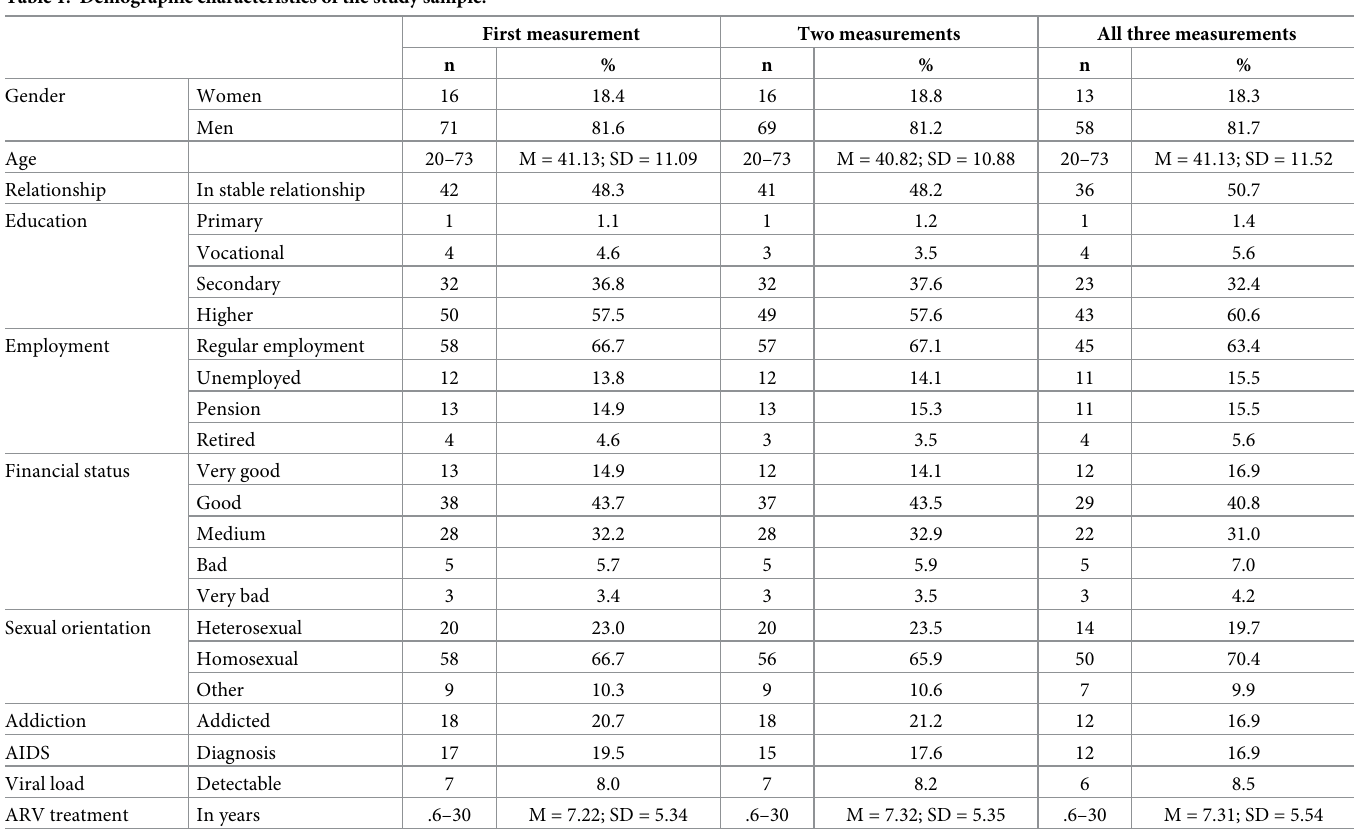
Table 1. Demographic characteristics of the study